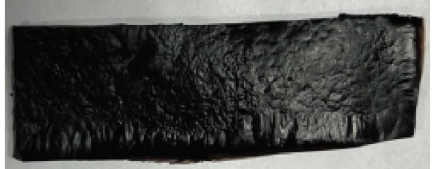
Figure 1: Sample of polyaniline/polyvinyl alcohol composite